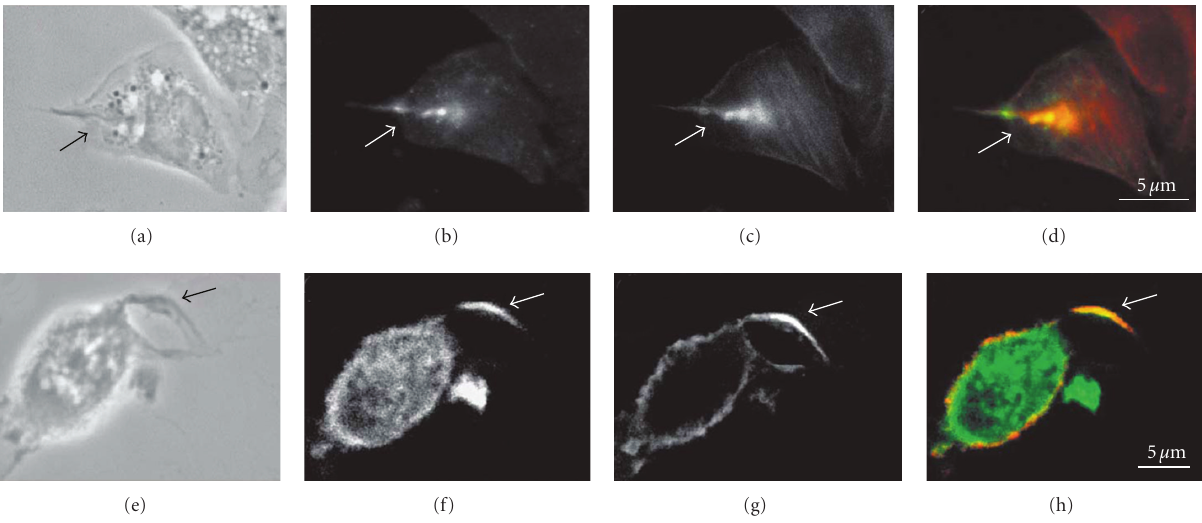
Figure 3: Immunofluorescence microscopy colocalization (arrows) of phosphorylated proteins (b, g), detected using antiphosphotyrosine antibody, actin filaments (c), detected using phalloidin, and PI3 kinase (f) detected using anti-PI3 Kinase antibody during penetration of T. cruzi into macrophages. The overlay images (d, h) show the areas of colocalization demonstrating that phosphorilated proteins and microfilaments participate in internalization of T. cruzi trypomastigotes by macrophages. Bars = 5 μ m (after